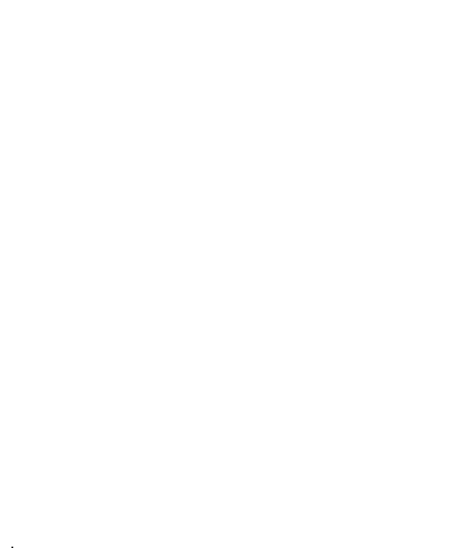
Fig 2. Study Population. AHS = Agricultural Health